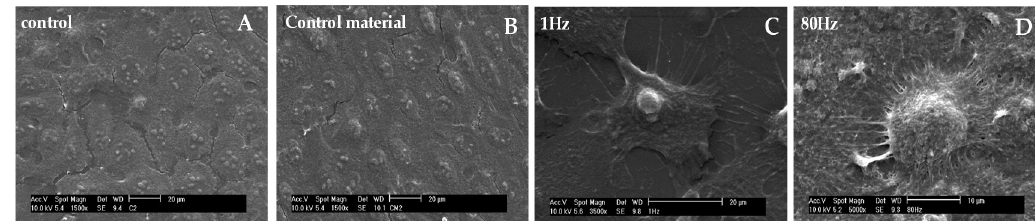
Figure 5. Electron microscopy images of samples under different conditions. The micrographics show difference in surface area and projections after stimulation. Non-significance is observed between controls ( A ) and static controls ( B ) at 48 h of observation. The morphology is clearly different between control groups (control ( A ) and control material ( B )) with 1 Hz samples ( C ) and 80 Hz samples ( D ). The 1 Hz stimulated group cells show cytoplasmic projections and condensed nucleus at 48 h. The 80 Hz stimulated group shows cells with rounded shape at 48 h. Length scale: 20 μ m.